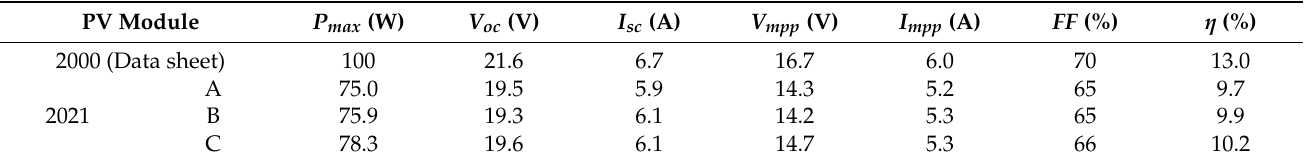
Table 1. Technical data sheet (2000) and the measured electrical parameters (2021) of old solar panels normalized to Standard Test Conditions